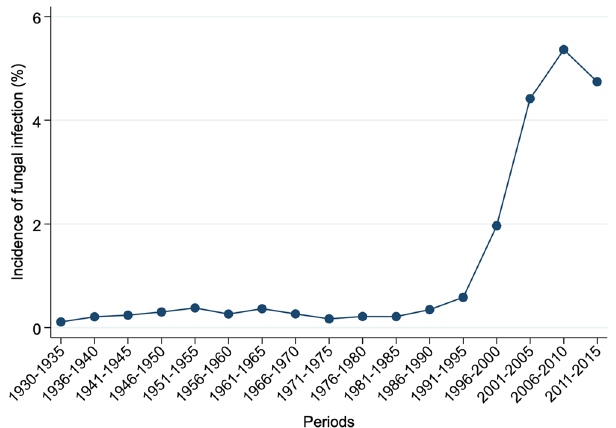
Figure 1. Annual evolution of the incidence of fungal infections among all death cases subjected to autopsy.